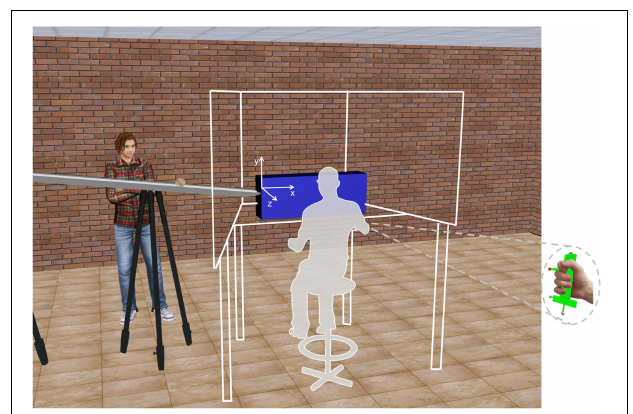
FIGURE 1 | Schematic of the experimental setup and visual scenario. The white lines and the gray area indicate the position of the mini-CAVE and the participant, respectively. The x , y , z reference system on the blue cuboid is shown for illustrative purpose only (it was not present in the virtual scene). The right inset shows the hitter held by the